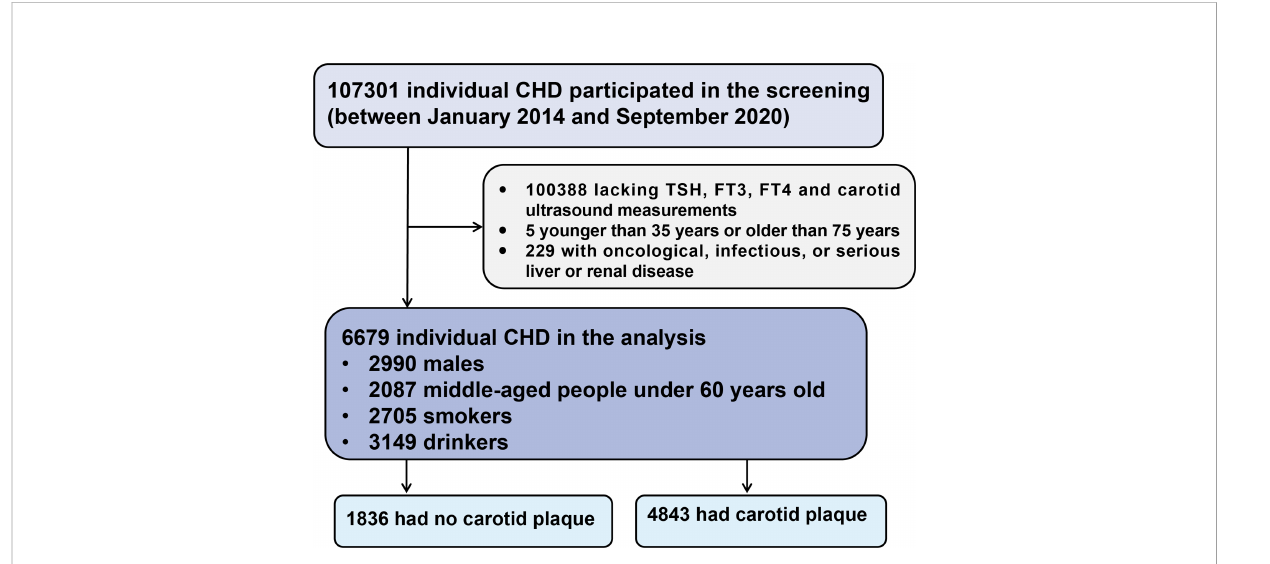
FIGURE 1 Flow chart of the study population. CHD, coronary heart disease; TSH, thyroid stimulating hormone; FT3, free triiodothyronine; FT4, free